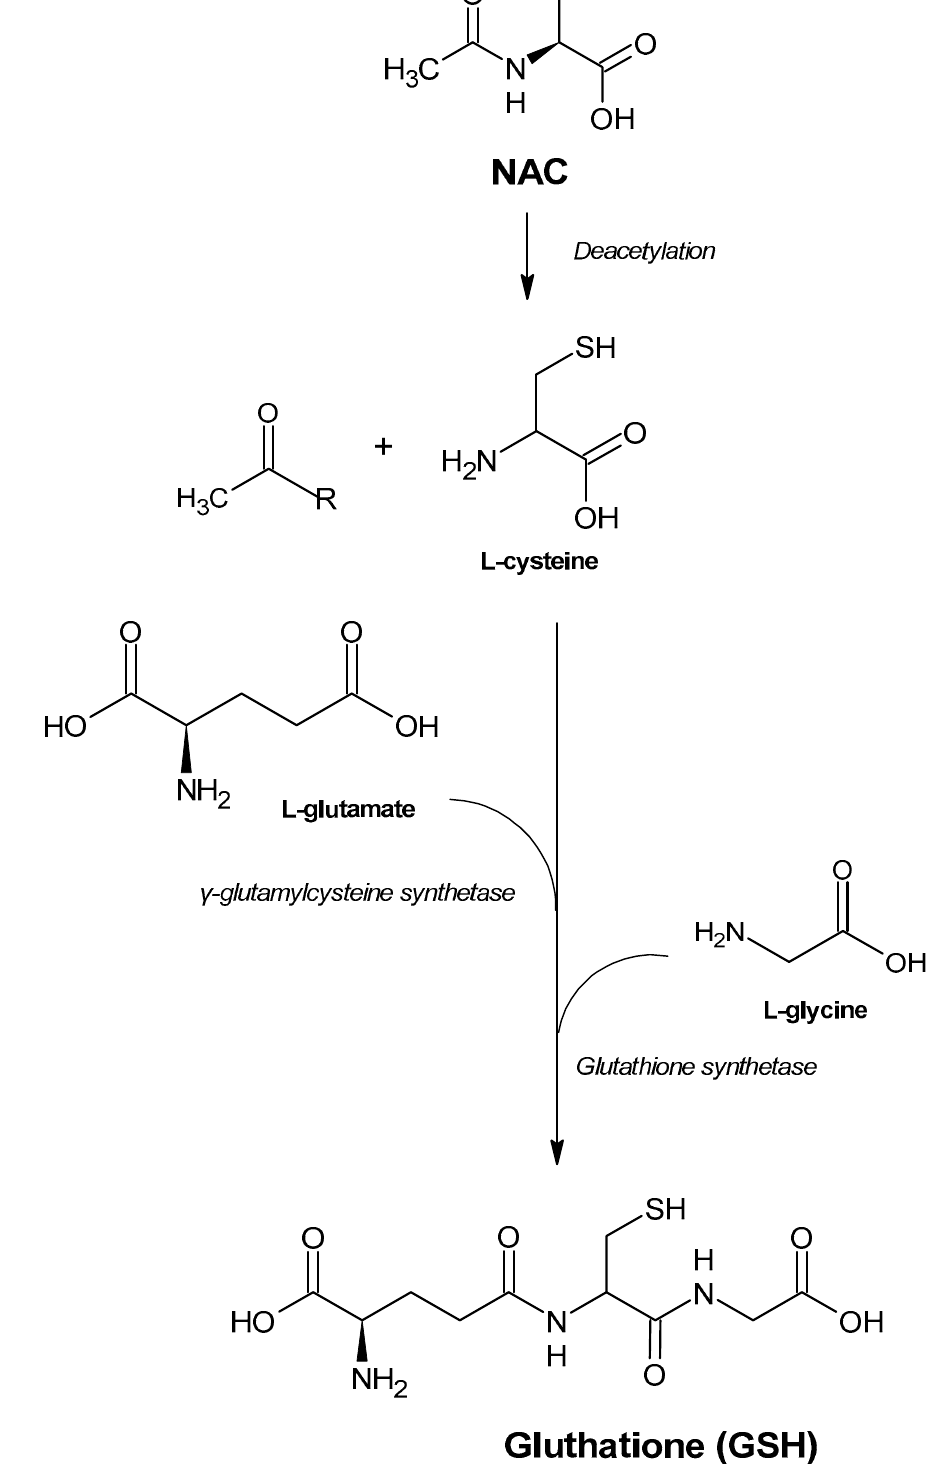
Figure 2. Chemical formula of N -acetylcysteine and its conversion to glutathione. Adapted from Rushworth and Megson (2014) [11].